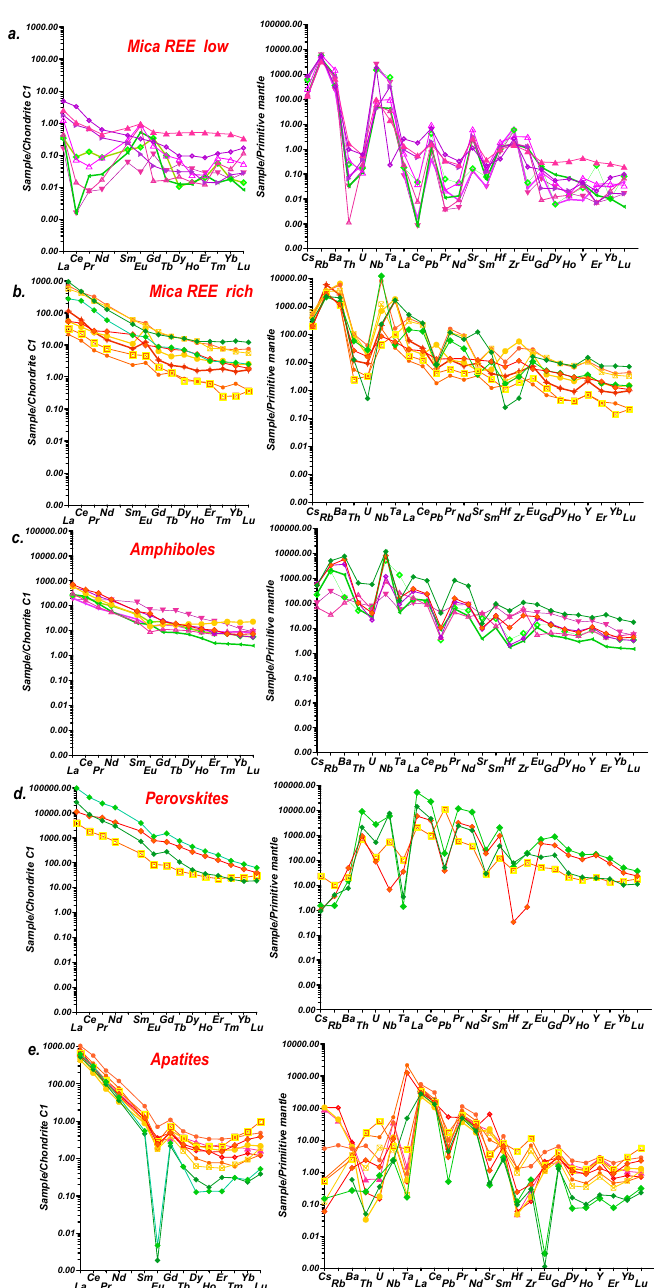
Figure 19. REE patterns and TRE spider diagrams of minerals from aillikites of Beloziminsky massif: for micas low in TRE ( a ); for micas high in TRE ( b ); for amphiboles ( c ); perovskites ( d ); apatites ( e ). Normalization to primitive mantle [61] and chondrite C1 [68].